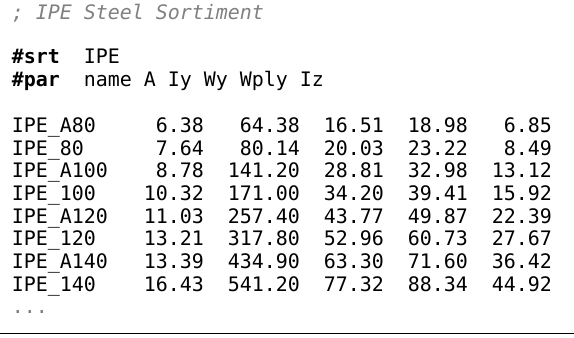
Fig. 15. A fragment of profile assortment file IPE.sec